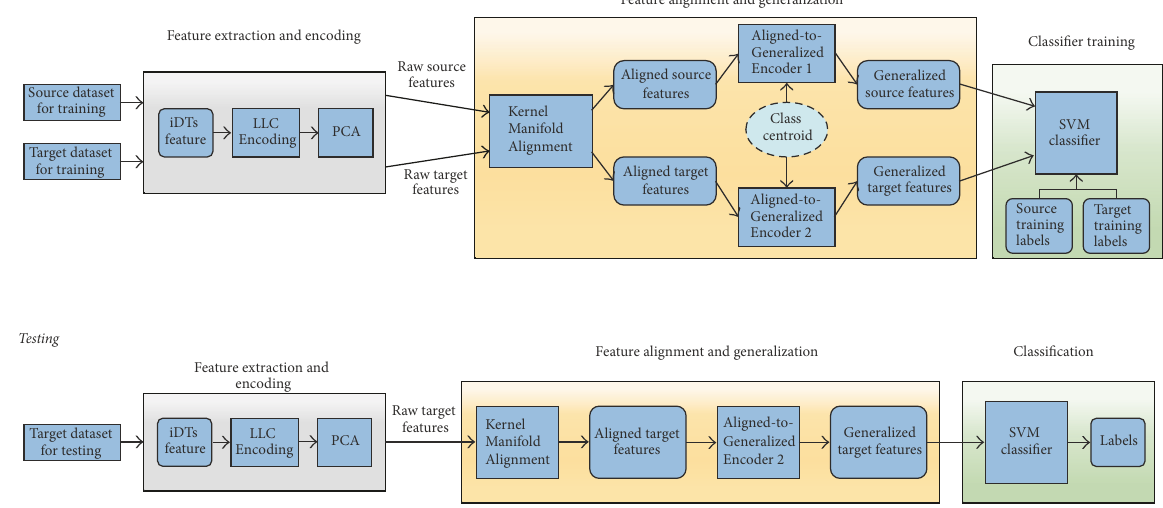
Figure 1: The framework of cross-dataset feature alignment and generalization (CDFAG). Top: training. Bottom: